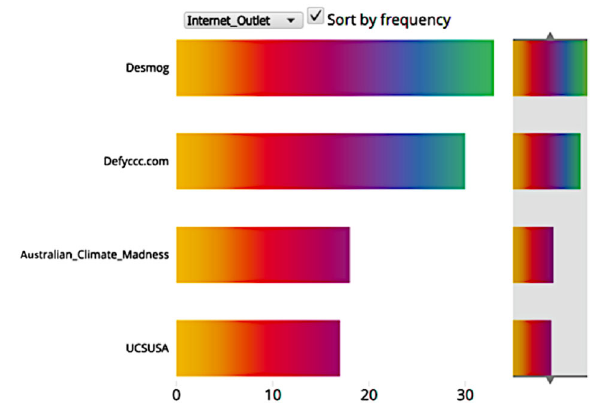
Fig. 1 Metafacet visualization for a concordance featuring bias /- es / -ed in CSBC (102 lines), fi ltered by Internet outlet and sorted by frequency.